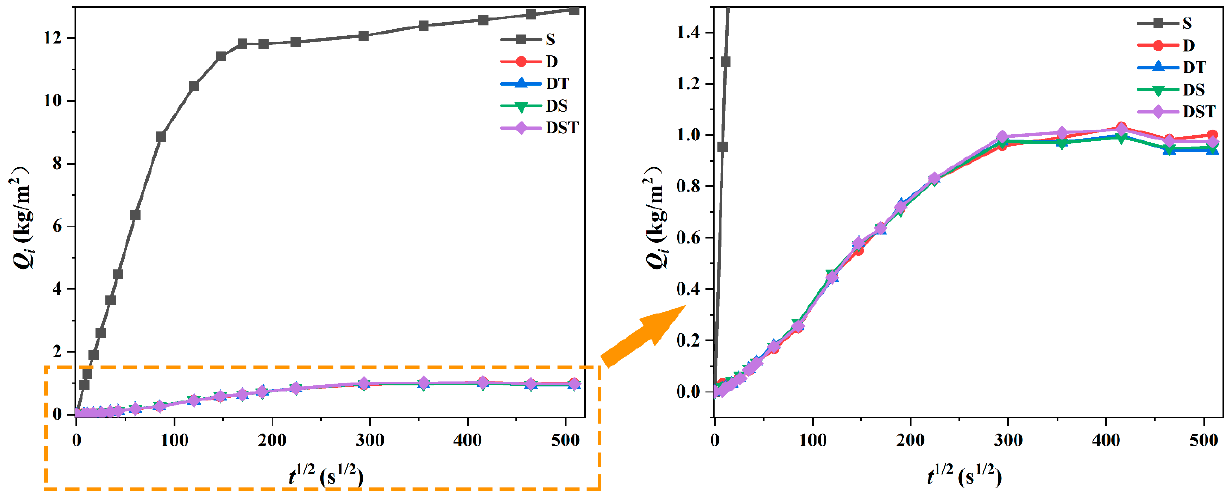
Figure 3. Capillary water-absorption curves.